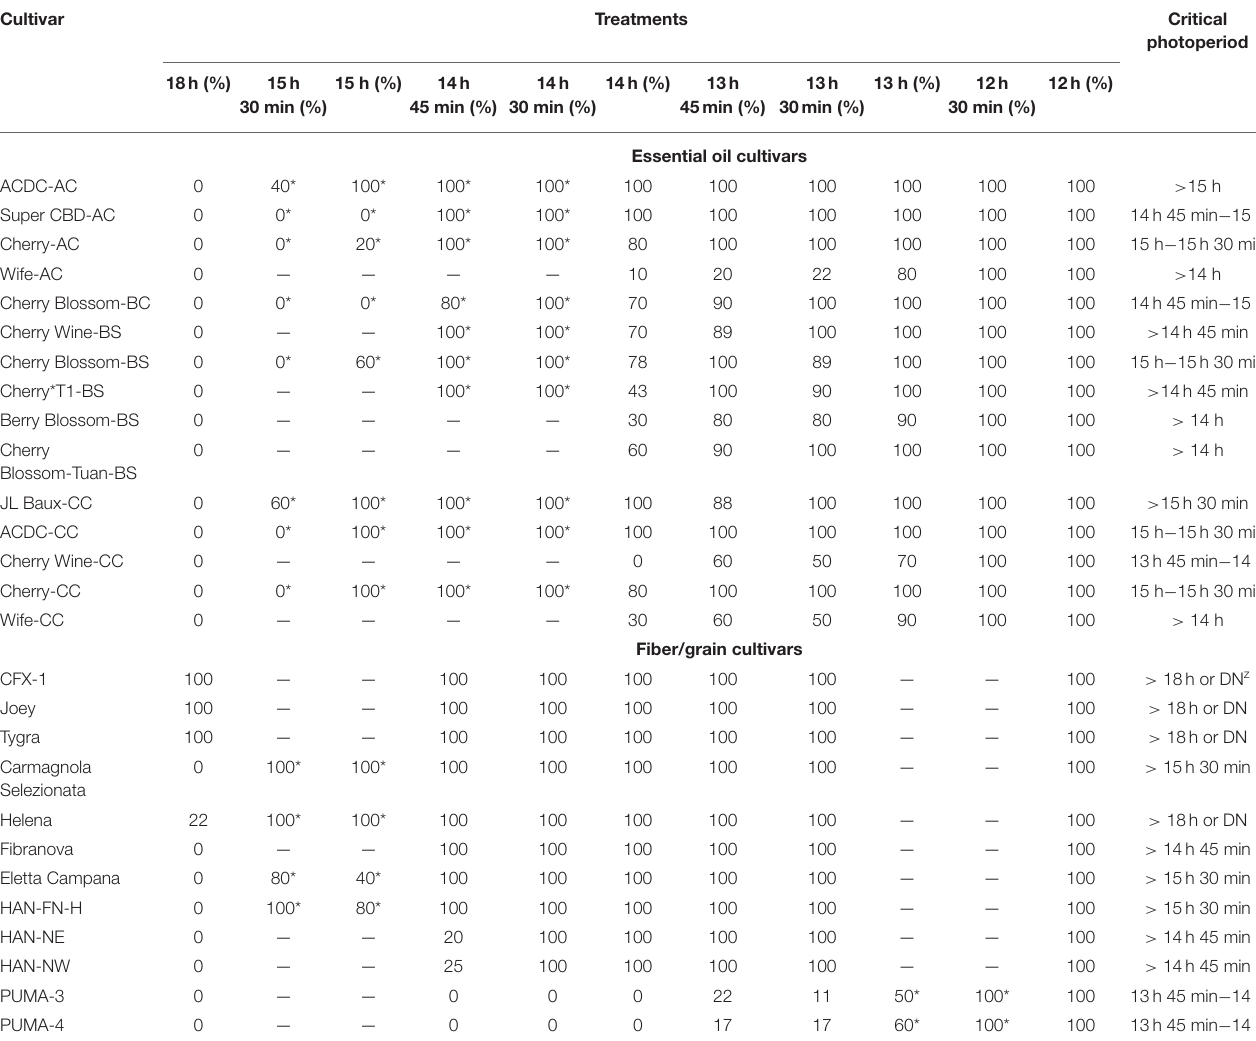
TABLE 1 | Flowering percentage of essential oil and fiber/grain hemp from Expt. 1, 2, and 3. Cultivar Treatments Critical